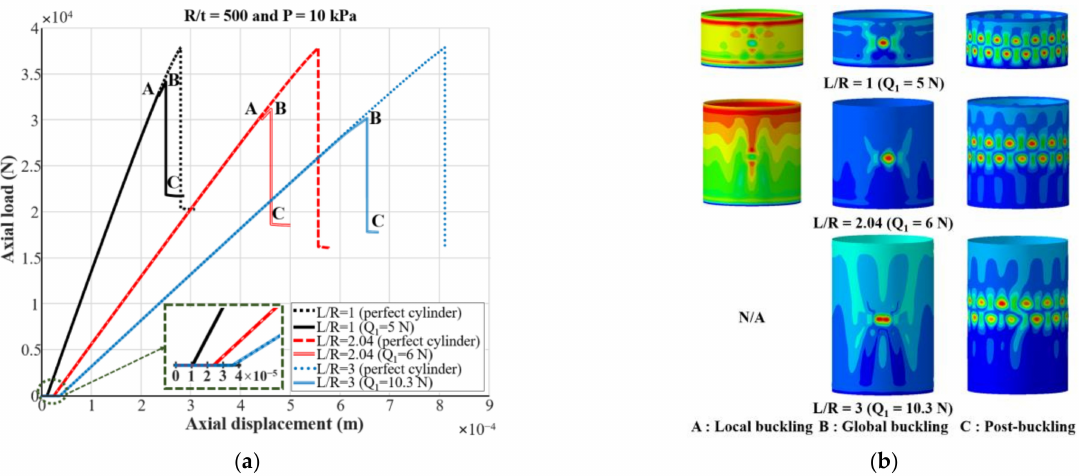
Figure 11. Post-buckling analyses results under axial compression and internal pressure (10 kPa) for the cylinders R / t = 500. ( a ) Load-displacement curves, ( b ) Buckling